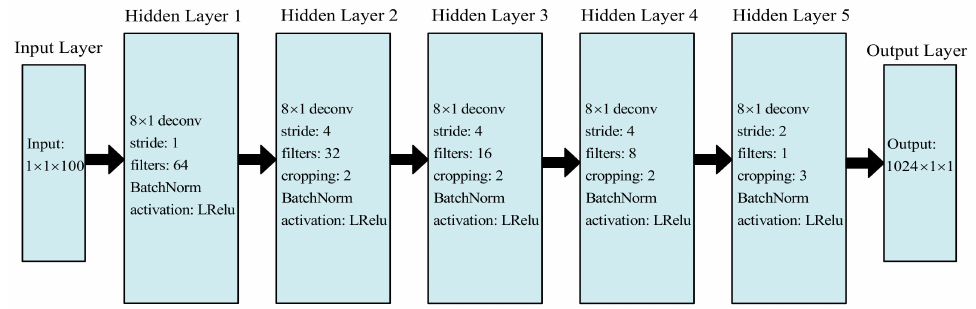
Figure 6. Detailed structure diagram of the generative